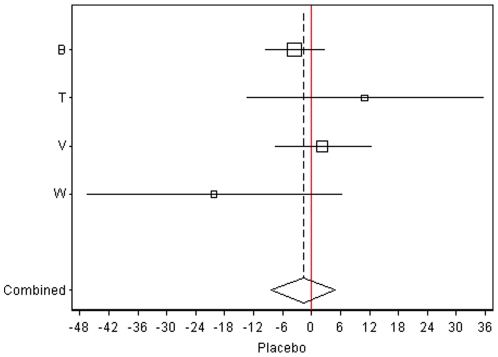
Associations (with 95% CI) of living within 100 m of a highway and CIMT progression and the respective meta-analytic estimates among the on-trial placebo group (treatment group: see Figure 4).EPAT: no subject lived within 100 m of a highway. The X-axis indicates the regression coefficient (change) in micrometers. The solid line indicates the level of no effect. Studies: B = BVAIT, T = TART, V = VEAPS, W = WELLHART.